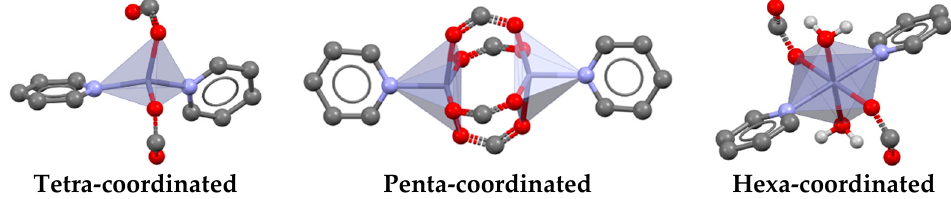
Figure 1. Three favored coordination modes of zinc complexes involving pyridine and carboxylate ligands, as identified in the CSD.